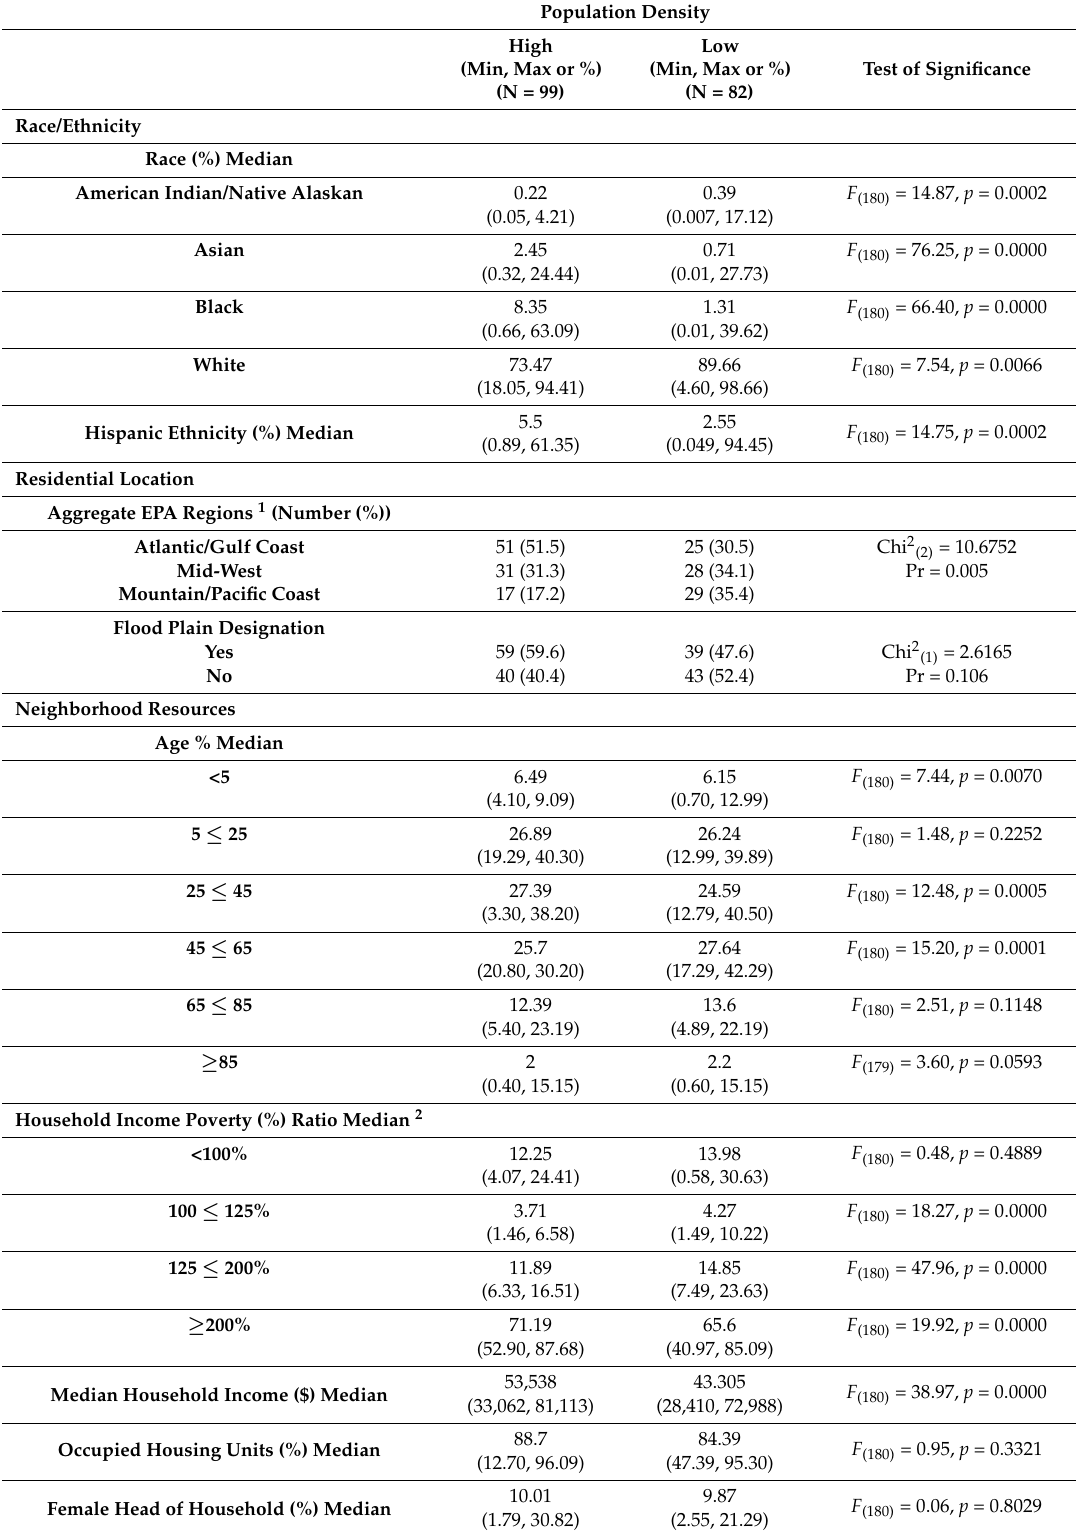
Table 2. County race/ethnicity, residential location, neighborhood resources, community stress, and structural factors by population